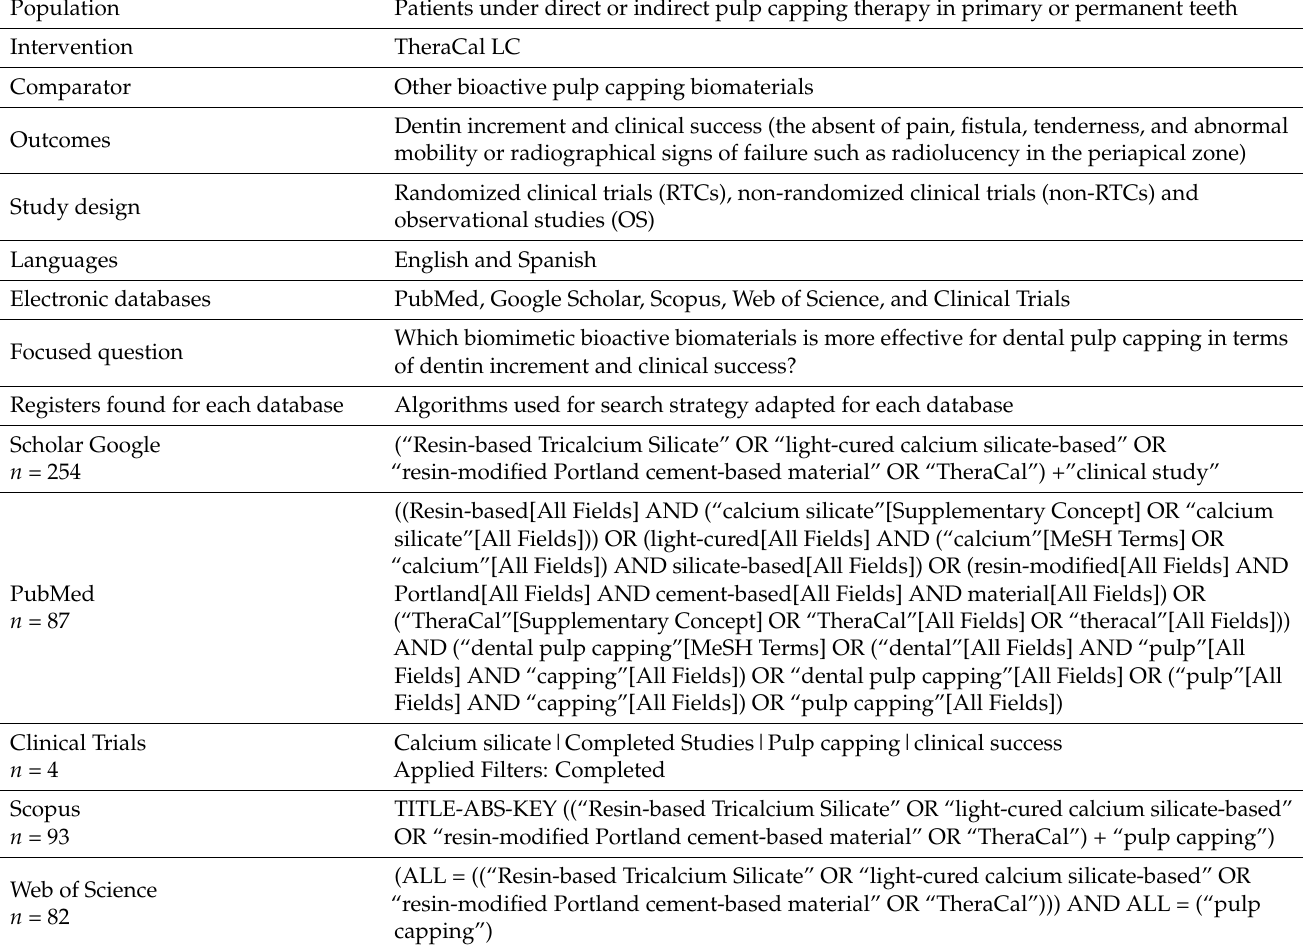
Table 1. PICO and search strategy for the systematic review of the light-cured calcium silicate- based